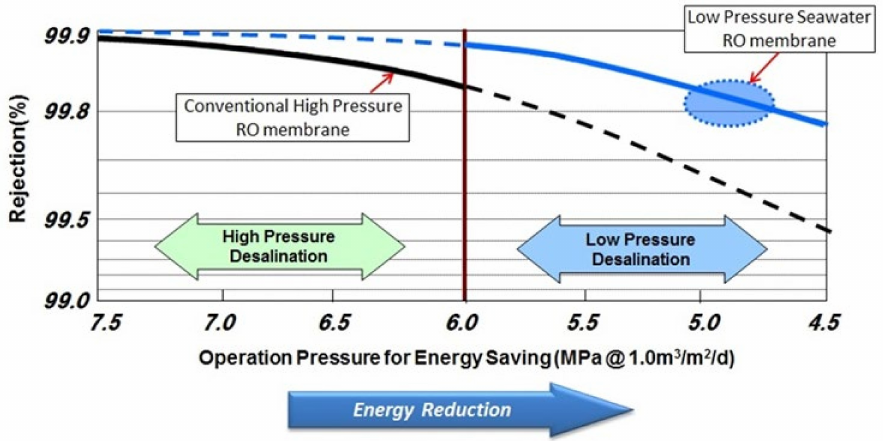
Figure 11. Comparison of conventional high-pressure Seawater Reverse Osmosis (SWRO) membrane and low-pressure SWRO membrane